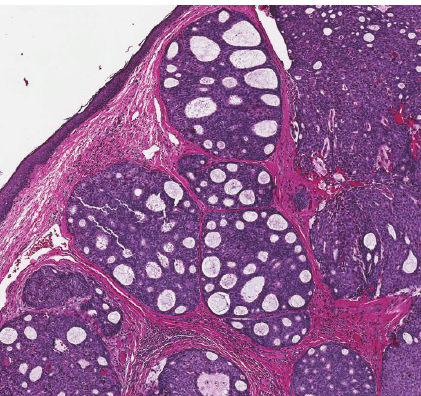
Figure 1: Low power H&E slide. The lobular architecture with cribriform pattern can be identified. There is no connection to the epidermis.